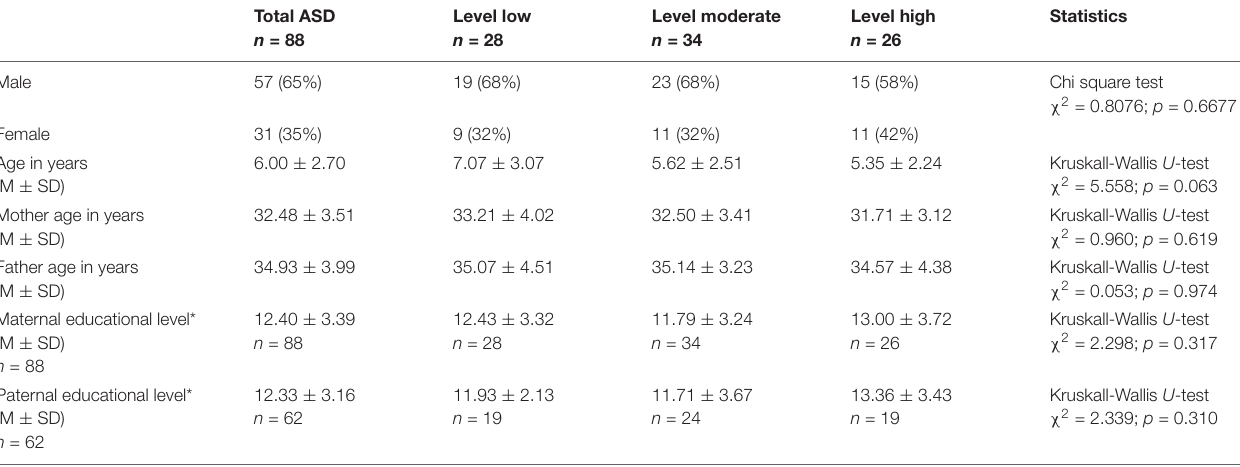
TABLE 1 | Sample characteristics.